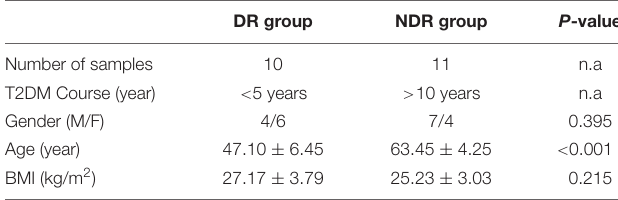
TABLE 1 | Characteristics of DR and NDR